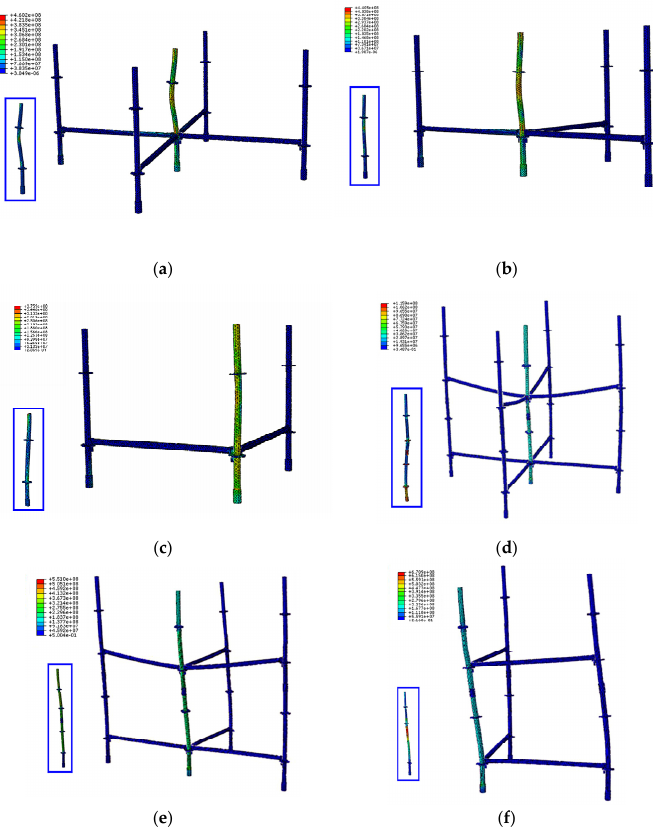
Figure 29. Deformation diagrams of single- and double-layer vertical pole structures: ( a ) Central pole of a single-layer structure; ( b ) side pole of a single-layer structure; ( c ) corner pole of a single- layer structure; ( d ) central pole of a double-layer structure; ( e ) side pole of a double-layer structure; ( f ) corner pole of a single-layer structure.